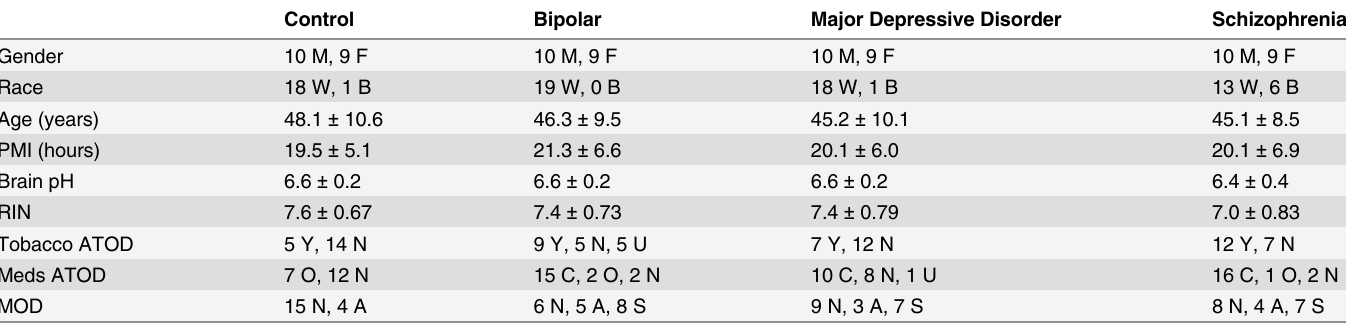
Table 1. Human subject demographics and sample metadata. Values are mean ± standard deviation (n = 19 per group): RIN = RNA Integrity Number; Medication at time of death (Meds ATOD): C = centrally acting medications (Benzodiazepines, anticonvulsants, antidepressants, antipsychotics, lithium), O = other medications, U = unknown, N = none; MOD = Manner of Death (N = natural; A = accidental; S =